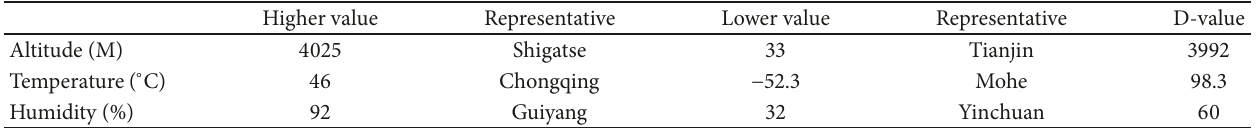
Table 2: Extreme statistics of environmental parameters in